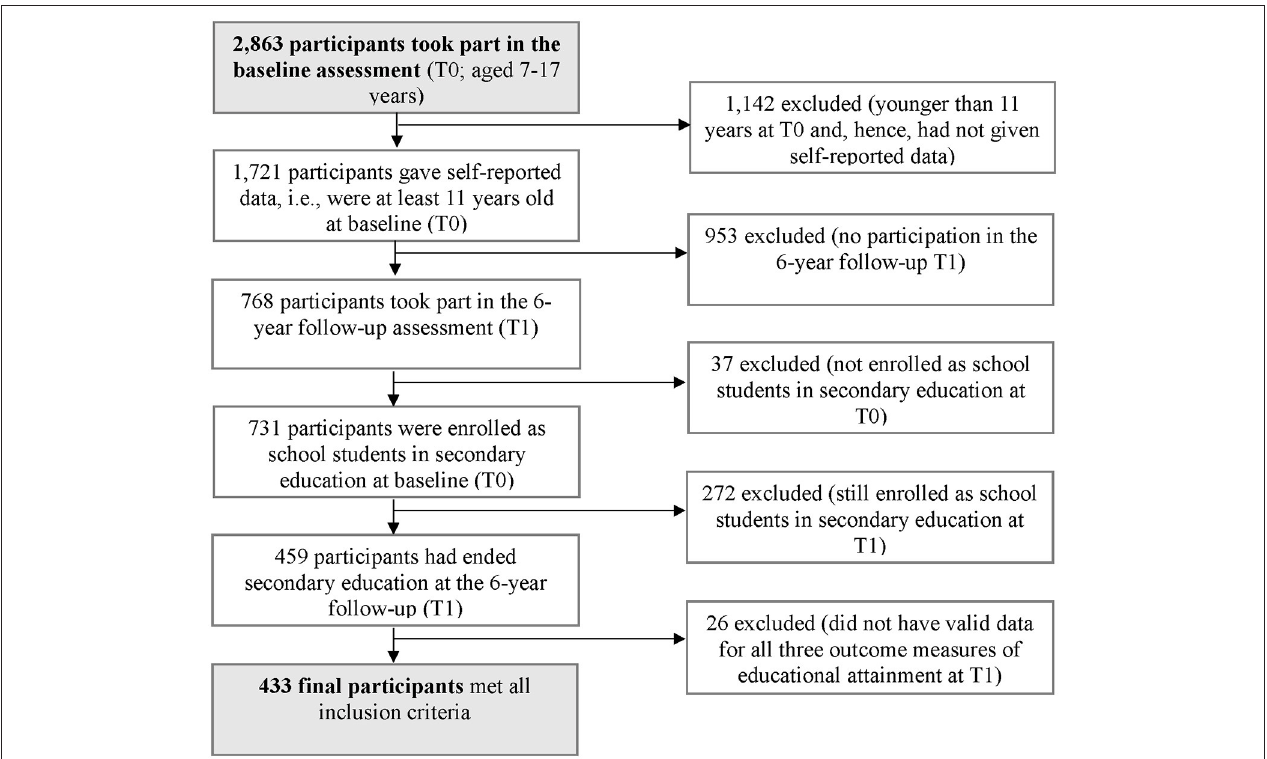
FIGURE 1 | Flow chart of the selection procedure for study